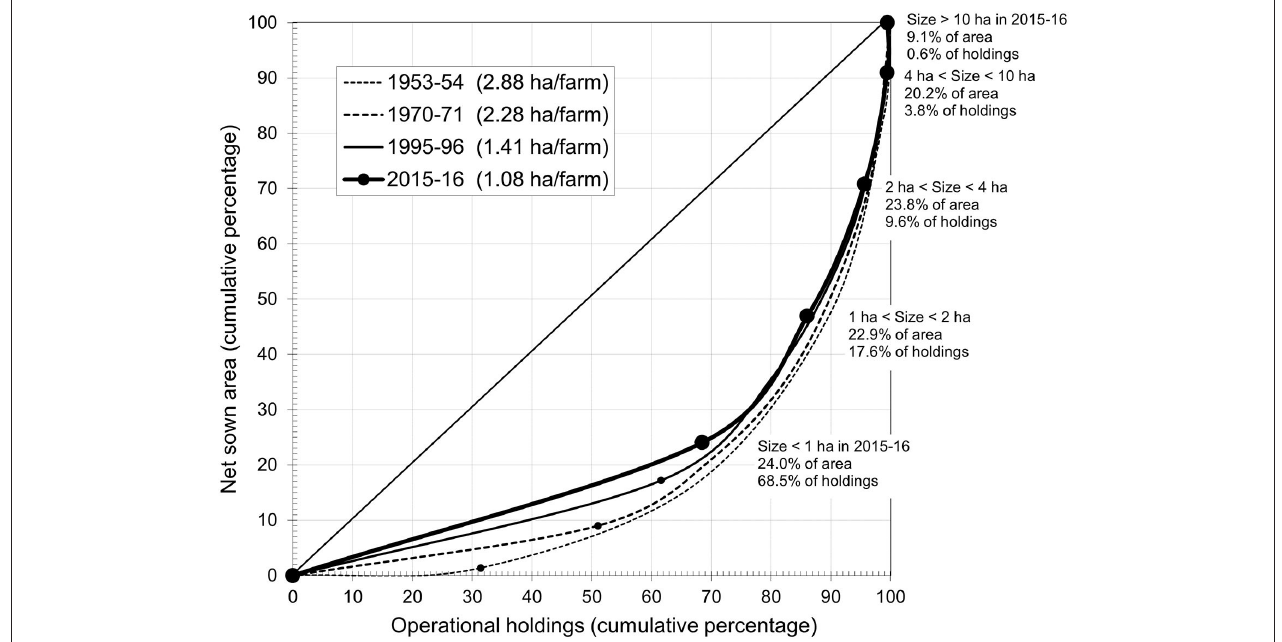
FIGURE 2 | Agricultural land distribution according to farm size (1953, 1970, 1990, 2015). Source: B. Dorin, based on Dorin and Landy (2009), Bhattacharjee (2020).